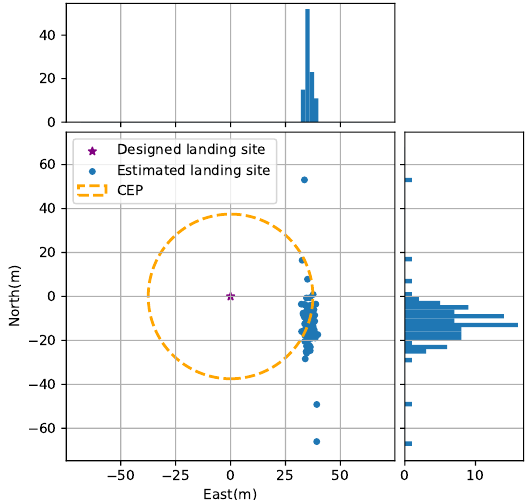
Figure 13. The circular error probable (CEP) of the proposed method from 100 independent Monte Carlo